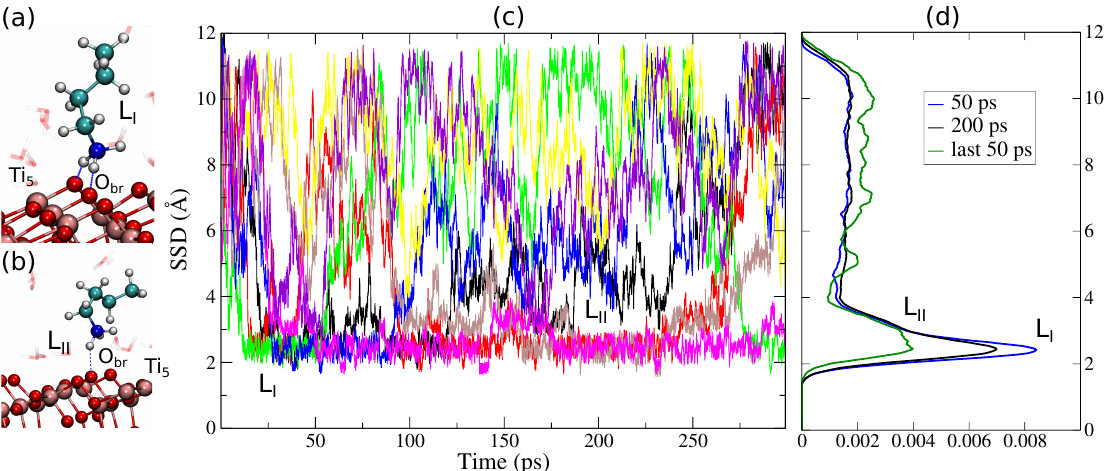
Figure 2. ( a , b ) Snapshots of adsorption modes L I at SSD = 2.5 Å and L II at SSD = 3.3 Å for Lysine on anatase (101). The freely diffusive water layers begin at SSD = 4 Å. ( c ) The surface separation distance (SSD) for the eight walkers used in the free energy calculations of Lysine, showing that the target collective variable is adequately sampled in 50 ps per walker. ( d ) The cumulative SSD distribution from all walkers at different times. No significant difference in the histogram is found after 50 ps per walker. The last 50 ps indicates that convergence is not reached with AWTMetaD after the full simulation